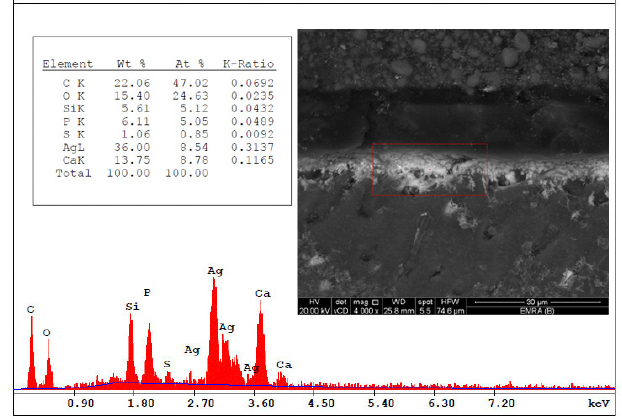
Figure 3. Selected scanning electron microscopy/energy- dispersive X-ray analysis at the resin-superficial dentin interfaces in teeth treated with total-etch technique. Image representative of 8 teeth.